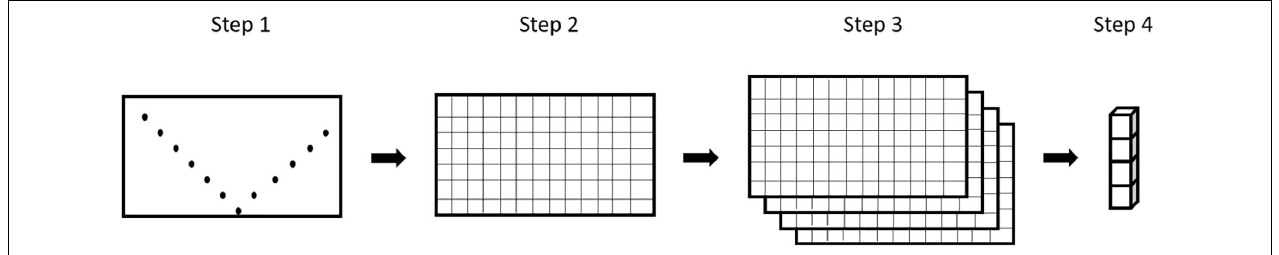
FIGURE 2 | Schematic data processing from measurements to feature-vector. Step 1: original measurements; Step 2: gridded parameter table; Step 3: stacked grids; Step 4: feature-vector for 1 of the 91 grid-cells.